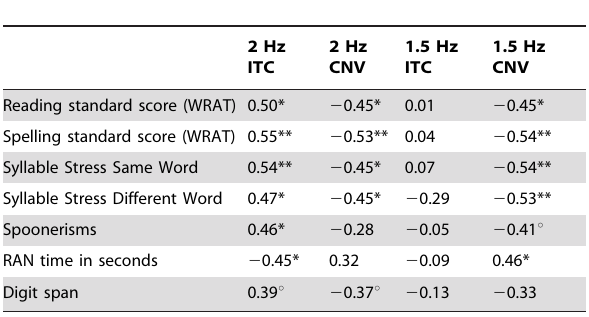
Table 2. Pearson correlations between ITC strength, CNV amplitude and the language measures for the two rhythmic presentation rates (2 Hz, 1.5